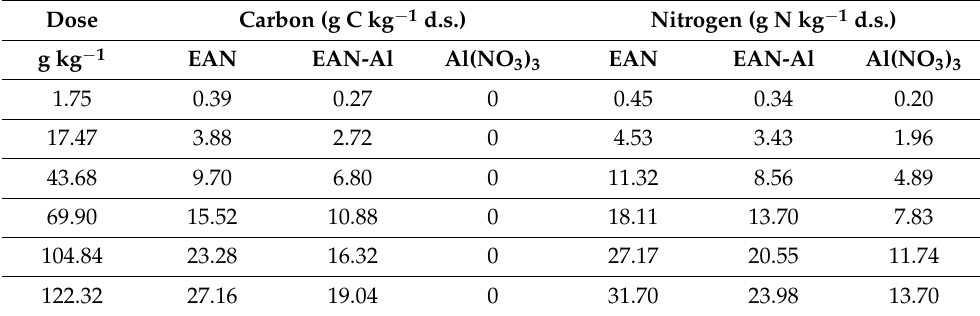
Table 3. Total amounts of C and N added to soils with the three compounds (d.s. = air-dried soil). Dose Carbon (g C kg − 1 d.s.) Nitrogen (g N kg − 1